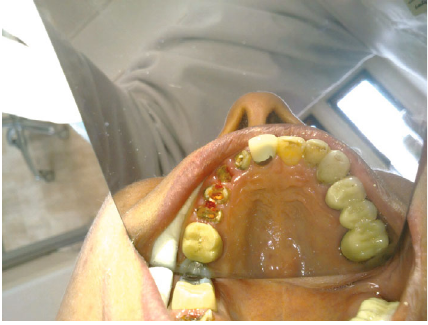
Figure 1: Occlusal view of central, lateral, canine, and premolars.